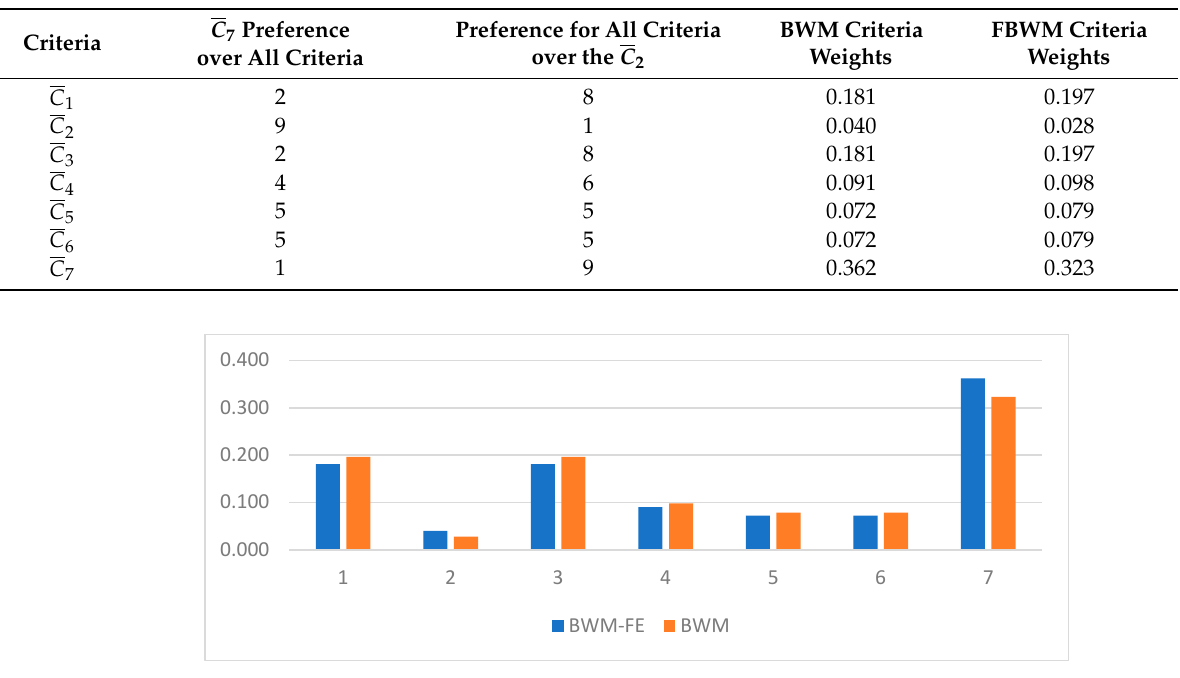
Figure 4. Brand criteria weights comparison. The vendors’ criteria and the corresponding symbols are presented in Table 5. Table 5. The vendor’s criteria and symbols. Nr.crt.